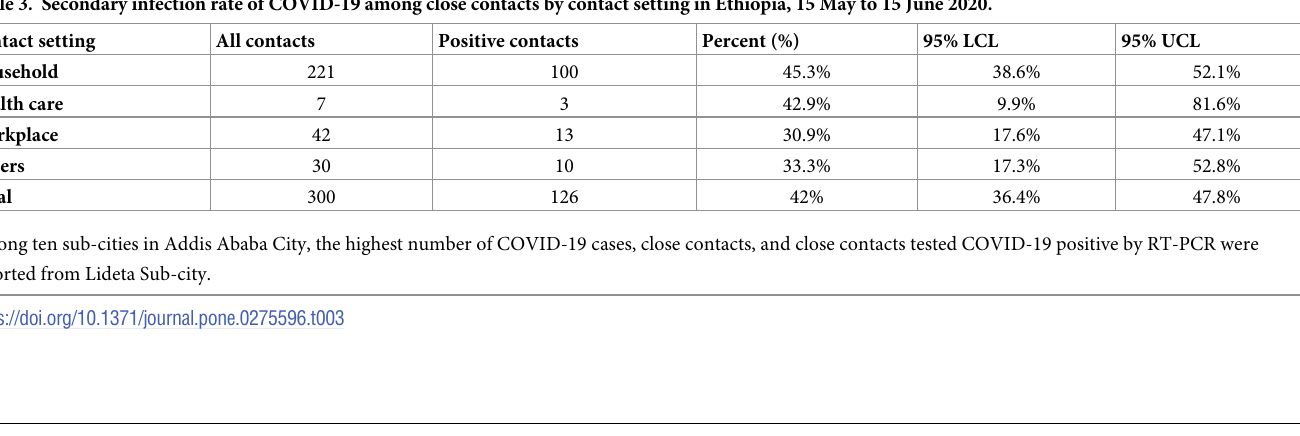
Table 3. Secondary infection rate of COVID-19 among close contacts by contact setting in Ethiopia, 15 May to 15 June 2020. Contact setting